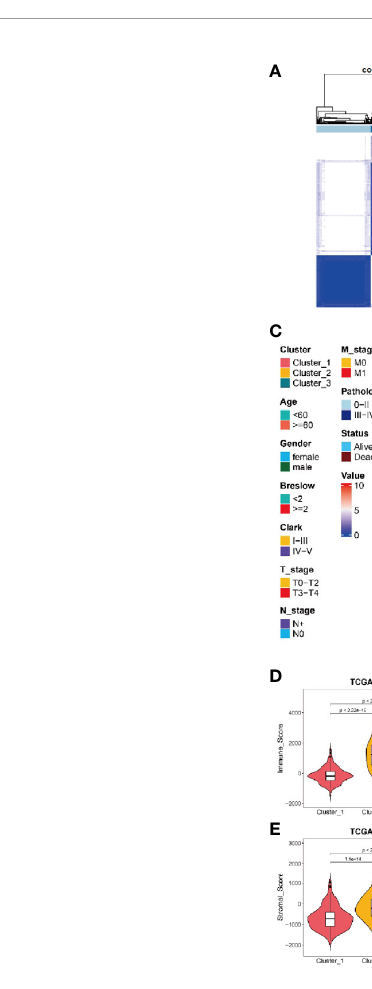
FIGURE 2 | Strati fi caton of melanoma patients via the expression of 184 TIRGs. (A) 448 melanoma patients from TCGA dataset are classi fi ed into three clusters based on the selected TIRGs by optima selection of unsupervised clustering. (B) Principle component analysis on the expression level of 184 TIRGs. (C) Clinical characteristics and RNA expression level of 184 TIRGs of melanoma patients from cluster 1, 2 and 3. (D, E) ESTIMATE analysis of immune score (D) and stromal score (E) shows a signi fi cant difference among three clusters in melanoma patients. (F, G) Melanoma patients in cluster 2 and 3 have signi fi cantly longer overall survival (F) and longer disease-speci fi c survival (G) than those in cluster